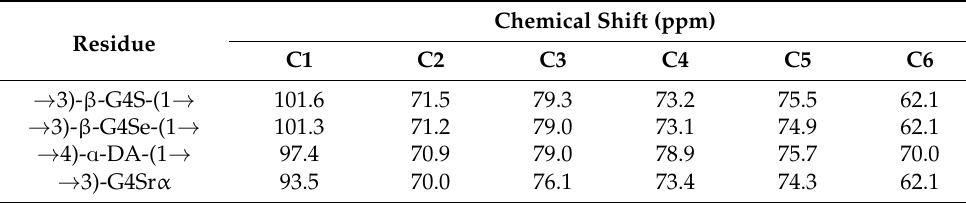
Figure 3 . NMR spectra of the KSCOs: ( A ) 1 H NMR spectrum; ( B ) 13 C NMR spectra. Blue indicates- chemical shift. Table 2. 13 C-NMR chemical shifts of κ -selenocarrageenan oligosaccharides. Table 1. 1 H-NMR chemical shifts of κ -selenocarrageenan oligosaccharides.